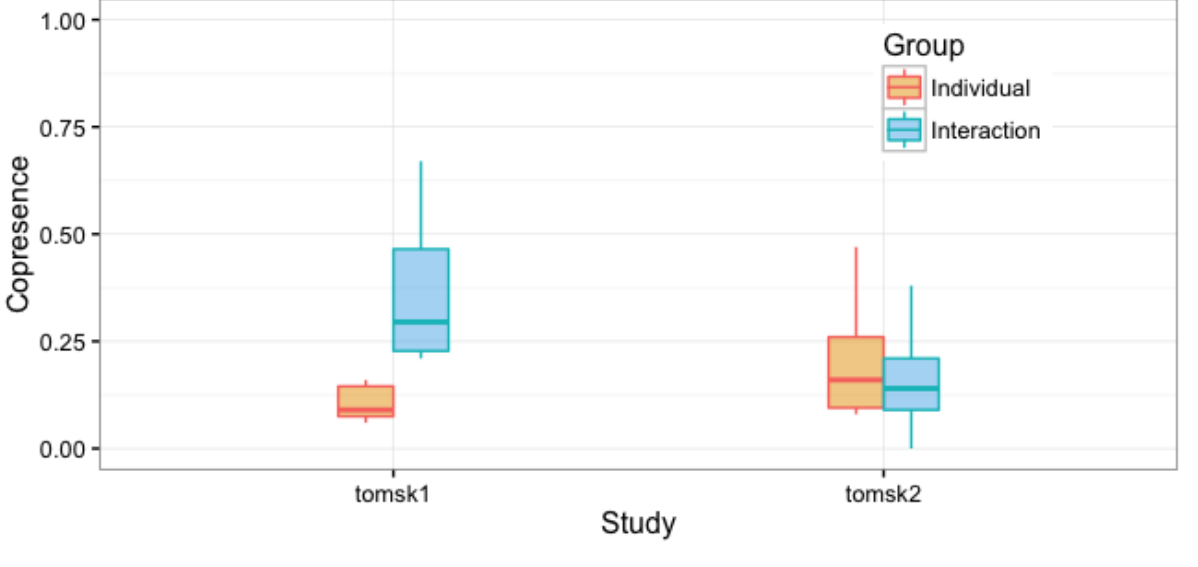
Figure 5. Copresence by study and